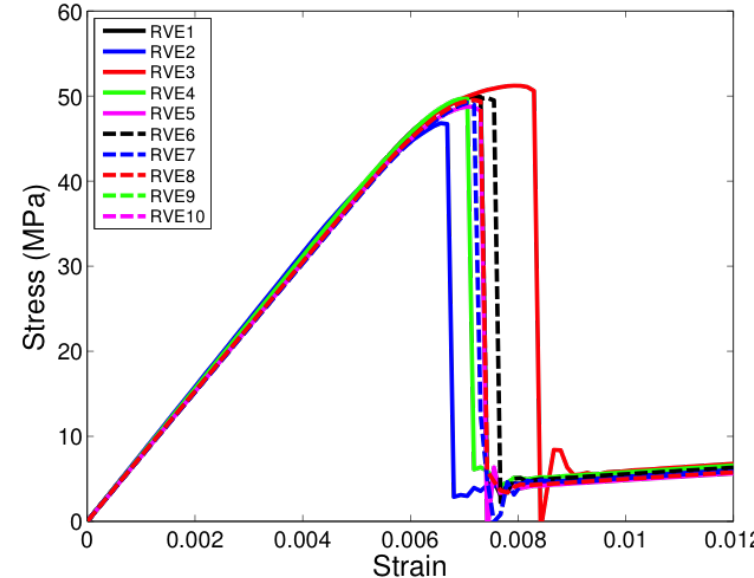
Figure 7. Transverse tensile response of six-fiber unit cells with V